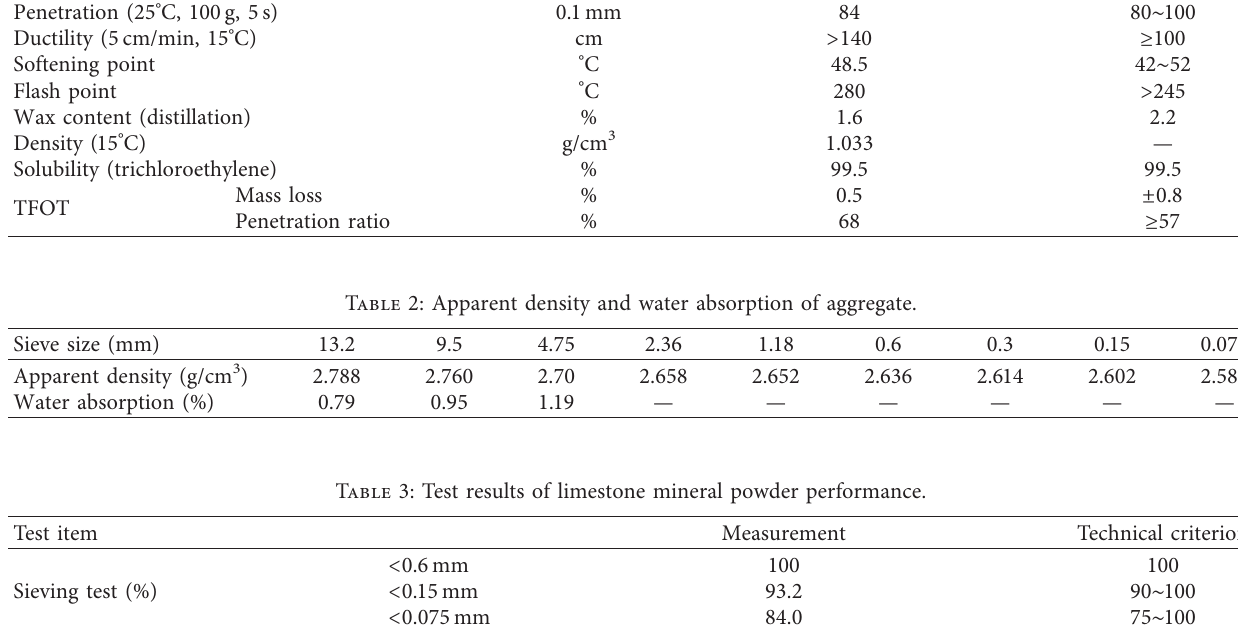
Table 1: Technical index of Liaohe-90 # matrix heavy traffic asphalt.